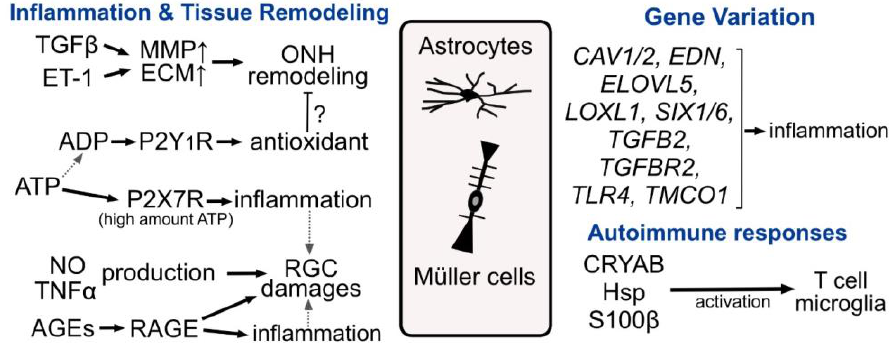
Figure 5. Glaucoma-related immune responses by astrocyte-lineage cells.